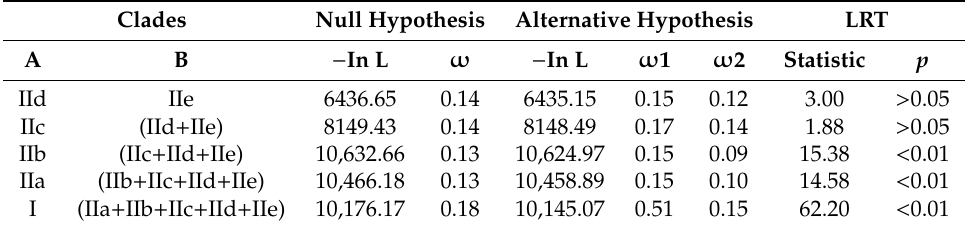
Table 2. The statistic and parameters from Branch model of PAML based on likelihood-ratio test (LRT). Clades